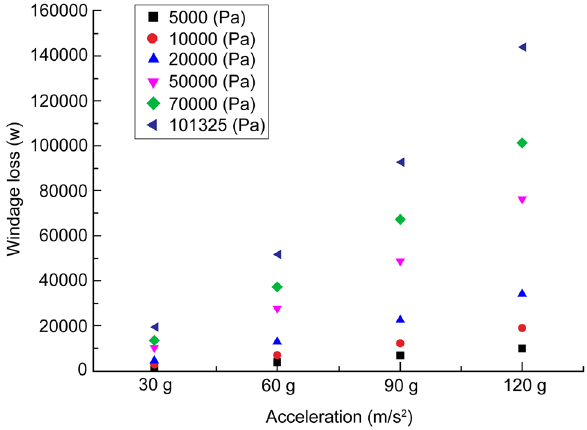
Fig. 9 Relationship between the windage loss and centrifugal acceleration under different operating